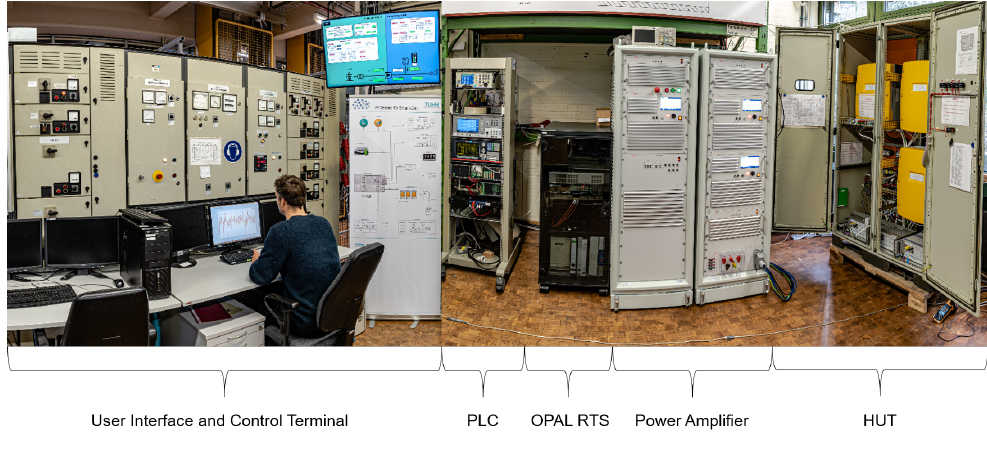
Figure 2. PHiLsLAB at TU Hamburg.